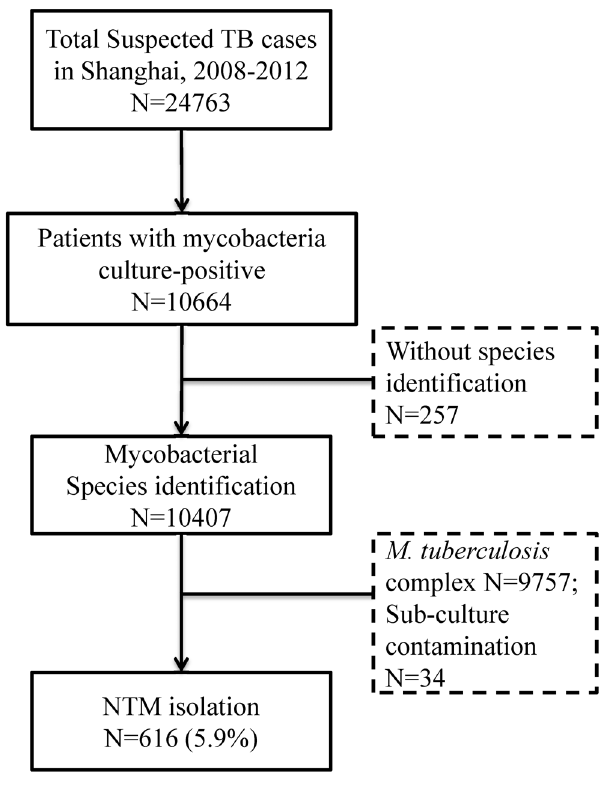
Figure 1. Isolation of nontuberculous mycobacteria from mycobacterial culture-positive patients in Shanghai, 2008– 2012. MTB, M.tuberculosis ; NTM, nontuberculous mycobacteria.